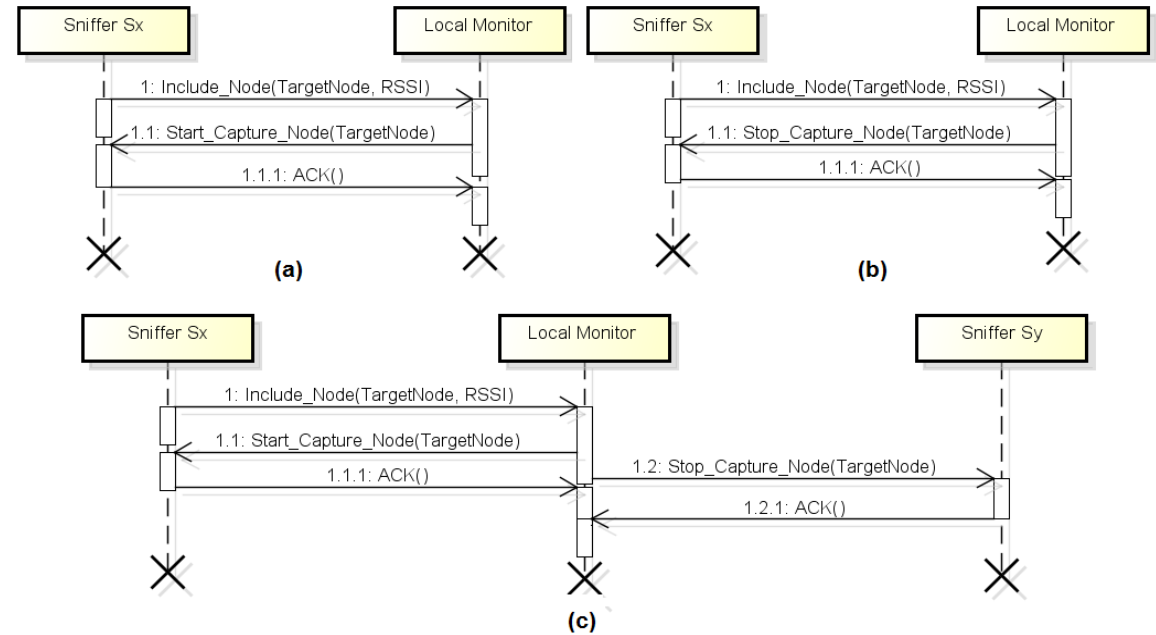
Figure 3. Sniffer election: ( a ) When no sniffer is capturing packets sent by the target node. ( b ) When S is capturing packets sent by the target node and RSSI(S Y ( c ) When S is capturing packets sent by the target node and RSSI(S Y